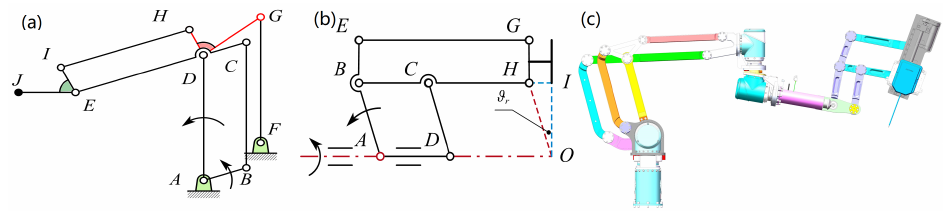
Figure 2. Puncture arm structure design. ( a ) Arm decoupling mechanism; ( b ) Wrist RCM mechanism; ( c ) Puncture arm structure.